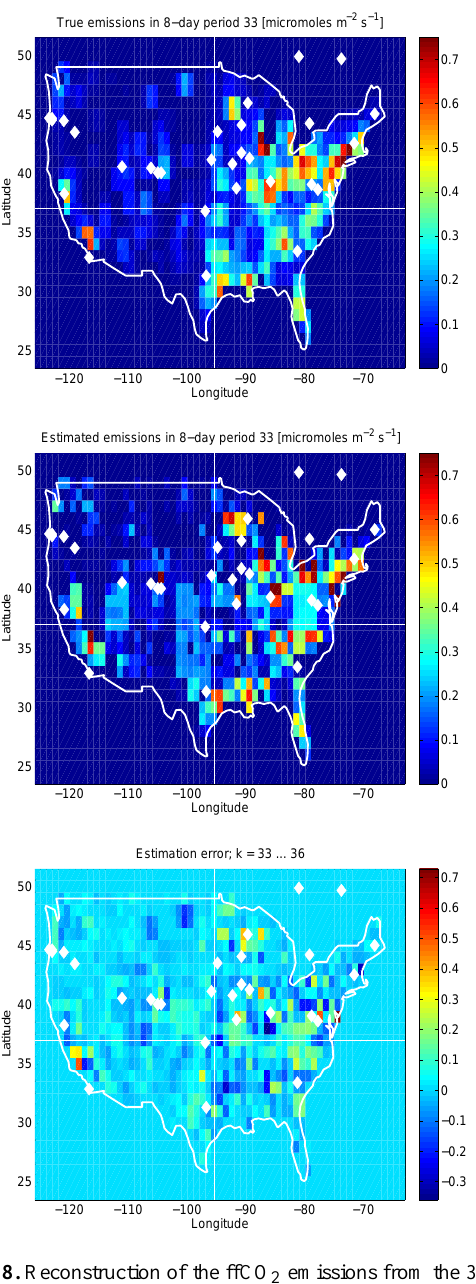
Figure 8. Reconstruction of the ffCO 2 emissions from the 35 tow- ers (plotted as diamonds). The true emissions are on top and the reconstructions in the middle. The figures represent emissions for k = 33 (end of August). At the bottom, we plot the estimation error, (E k − f V,k ) , averaged over 33 ≤ k ≤ 36. We see that the large-scale structure of the emissions have been captured. The west coast of the US has few towers near heavily populated regions and thus is not very well estimated. On the other hand, due to the higher density of towers in the northeast, the true and estimated emissions are qual- itatively similar and estimation error are low. Emissions have units of µmolm − 2 s − 1 of C (not CO 2 ).